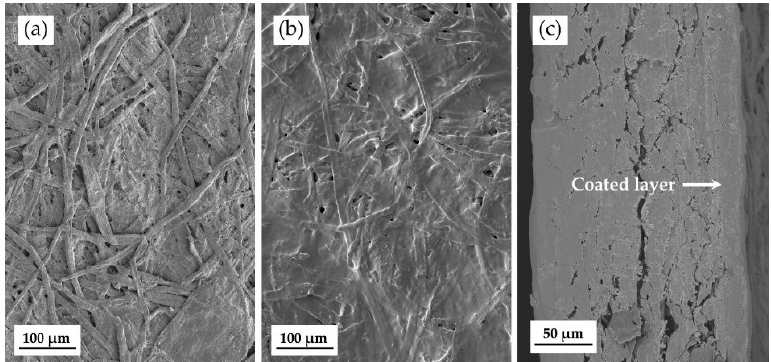
Figure 3. Field emission scanning electron microscope (FE-SEM) micrographs of ( a ) uncoated paper, ( b ) paper coated with AgNPs, and ( c ) cross-section of the surface coated with a layer of AgNPs.